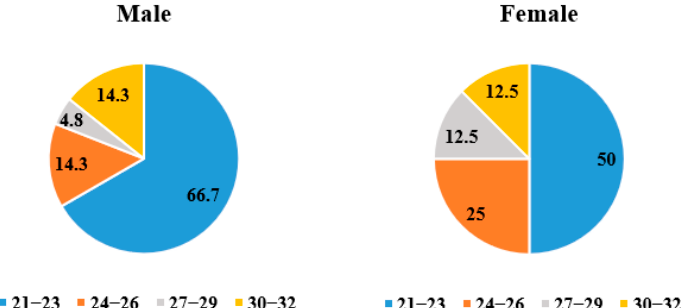
Figure 3. Gender distribution of the sample of users that performed the experimental VR session (by age group).